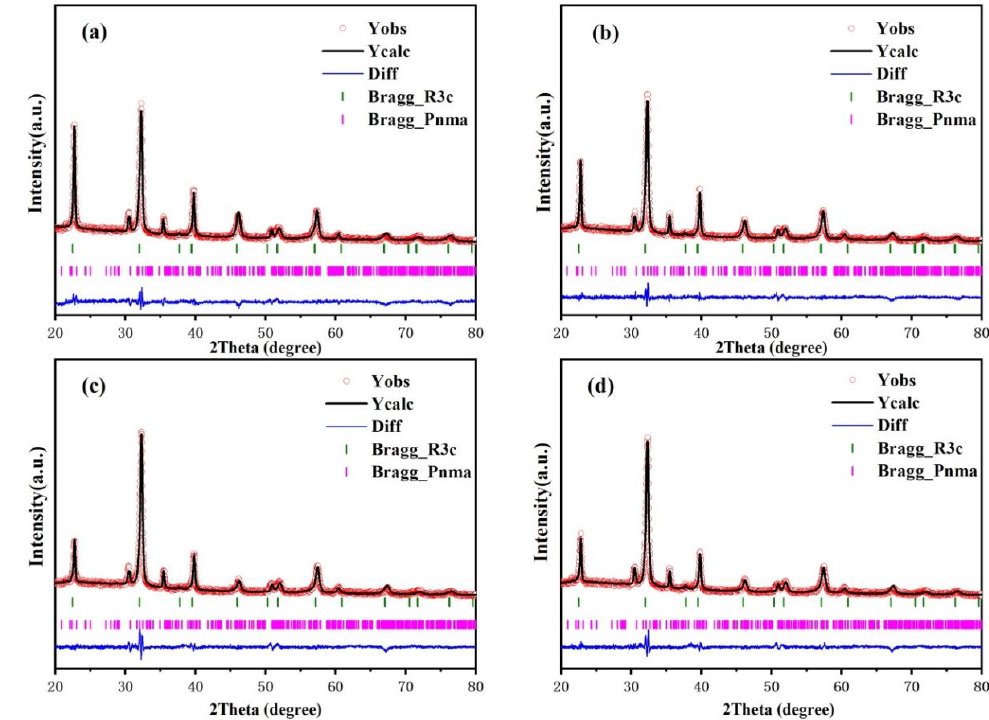
Figure 2. Rietveld refined XRD patterns of the BSFM films with different Sm content: ( a ) x = 0 mol%; ( b ) x = 2 mol%; ( c ) x = 4 mol%; ( d ) x = 6 Table 1. Rietveld refinement parameters of the BSFM films with different Sm content.